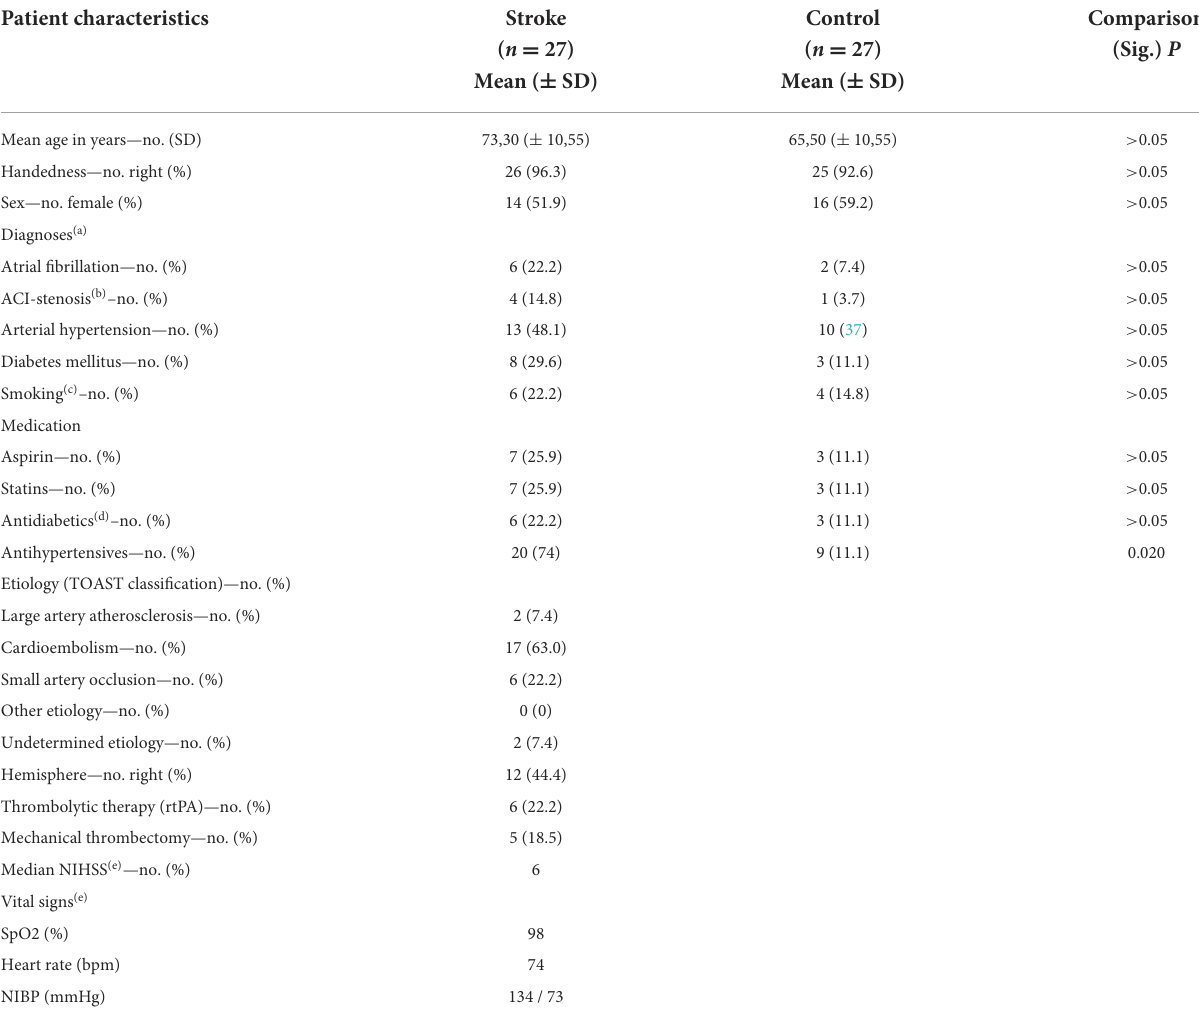
TABLE 1 Patient